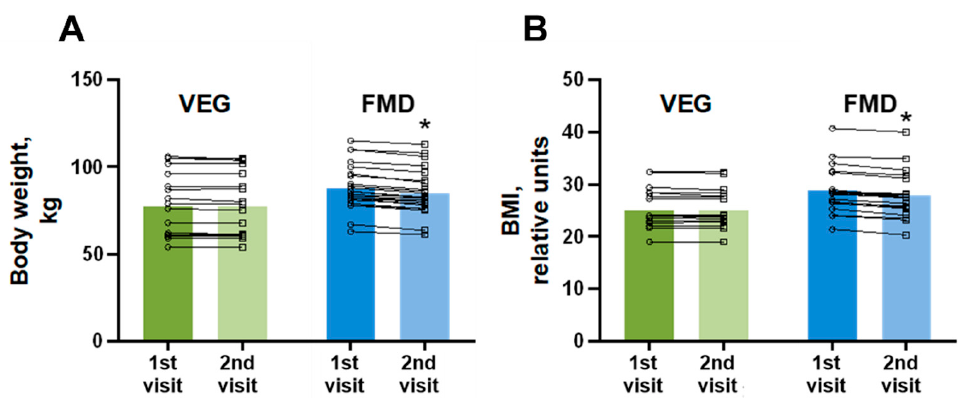
Figure 4. Effects of a 5-day regular diet with additional intake of vegetables (VEG) and fasting- mimicking diet (FMD) on weight ( A ) and BMI ( B ) in healthy volunteers. The results are presented as the mean and independent values of 19 volunteers in the VEG group and 24 volunteers in the FMD group. * Indicates a significant difference from the respective group at the 1st visit (Wilcoxon matched-pairs test), p < 0.05.